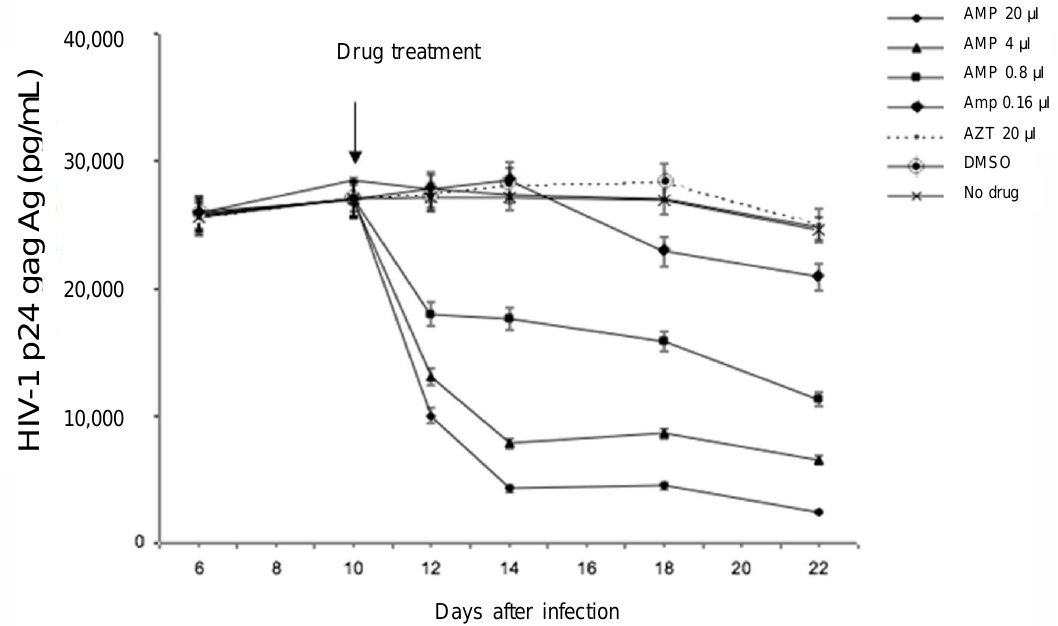
Figure 1. Kinetics of human immunodeficiency virus 1 (HIV-1) p24 gag Ag production in supernatants from HIV-1 chronically-infected monocyte-derived macrophages (MDM) treated with different doses of amprenavir (AMP). On Day 10 after infection, when HIV-1 infection becomes chronic, the drug was added to chronically-infected MDM. The figure reports data from a single experiment (each time point run at least in triplicate), which is representative of three different